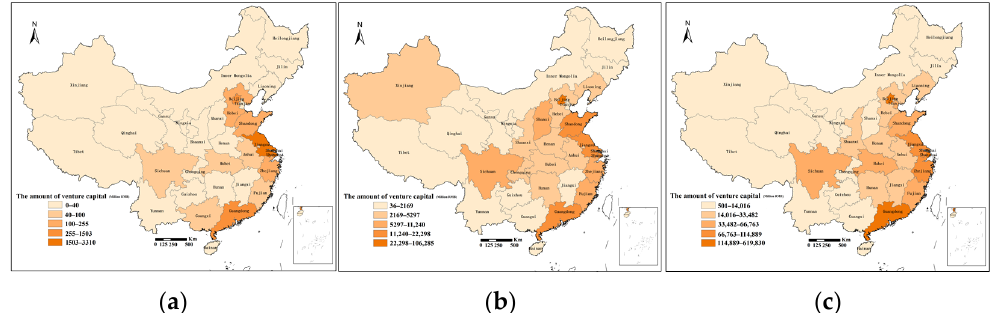
Figure 1. Spatial segmentation map of China venture capital in 2003 ( a ), 2010 ( b ), and 2018 ( c ).